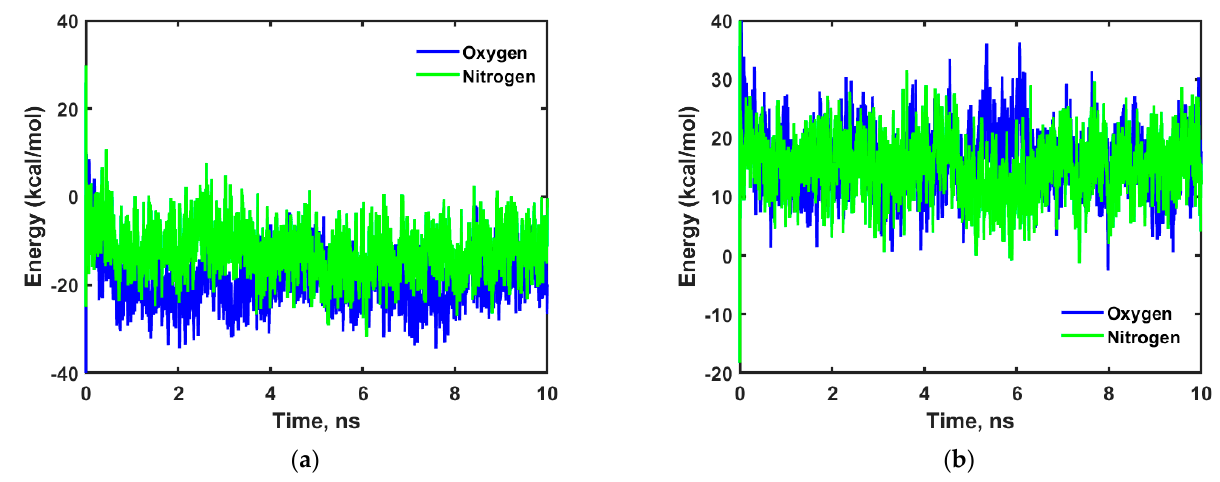
Figure 7. Time versus interaction energy for oxygen and nitrogen in ( a ) cellulose and ( b ) adulose.